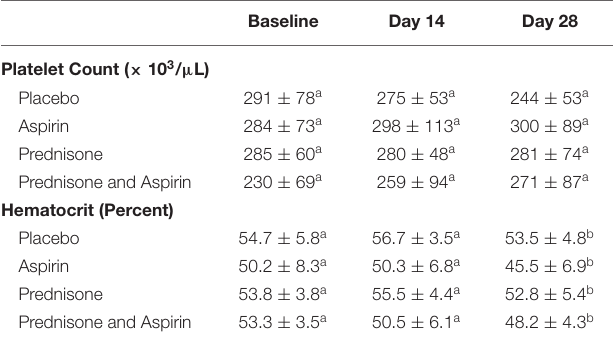
TABLE 1 | Mean ± standard deviation platelet counts and hematocrits for 24 healthy dogs administered placebo, aspirin with placebo, prednisone with placebo, or combination prednisone and aspirin therapy for 28 days.